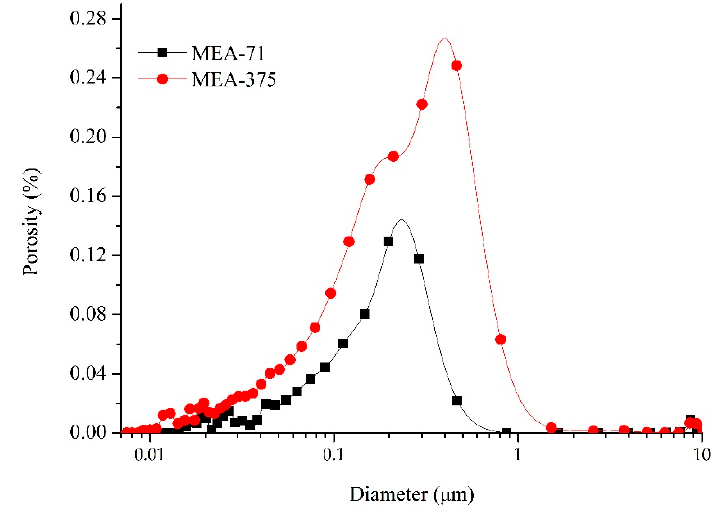
Figure 8. Pore size distribution of compacted MEA-71 and compacted MEA-375 cured in water at 40 °C when the expansion stresses stabilized.